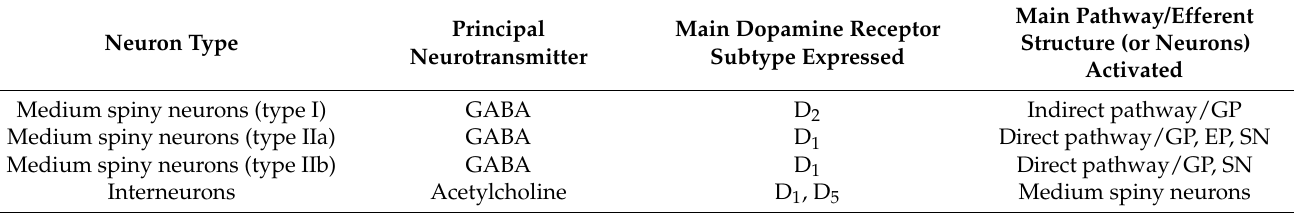
Table 1. Main cell types in the striatum 1